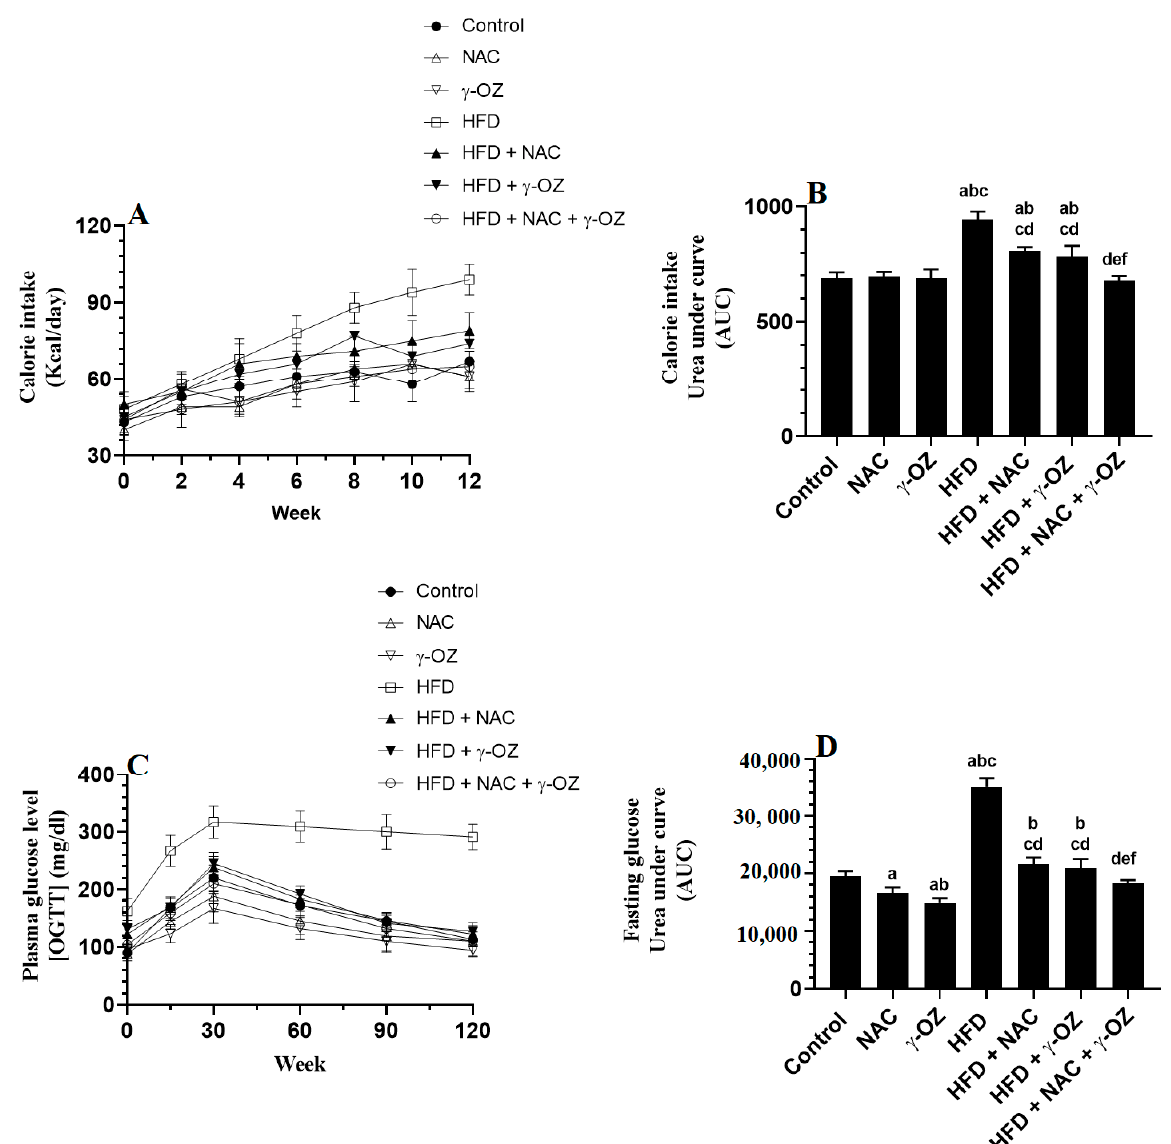
Figure 1. γ -Oryzanol (OZ) and N-acetylcysteine (NAC) and their combination reduces calorie intake and improves oral glucose tolerance test (OGTT) in high-fat-diet (HFD)-fed rats. ( A ): average of weekly calorie intake; ( B ): the corresponding area under the curve (AUC) of the average calorie intake of rats; ( C ): levels of plasma glucose measured before and after the OGTT; and ( D ): AUC of glucose levels measured post-OGTT in ( C ) in all groups of rats. Data are presented as means ± SD (n = 8/group). The value of significance was determined at p < 0.05. a: significantly different as compared to the control group; b: significantly different as compared to the NAC-treated control rats; c: significantly different as compared to the γ -oryzanol-treated rats; and d: significantly different as compared to the HFD-fed group; e: significantly different as compared to the HFD + NAC-treated rats; and f: significantly different as compared to the HFD + γ -oryzanol-treated rats.